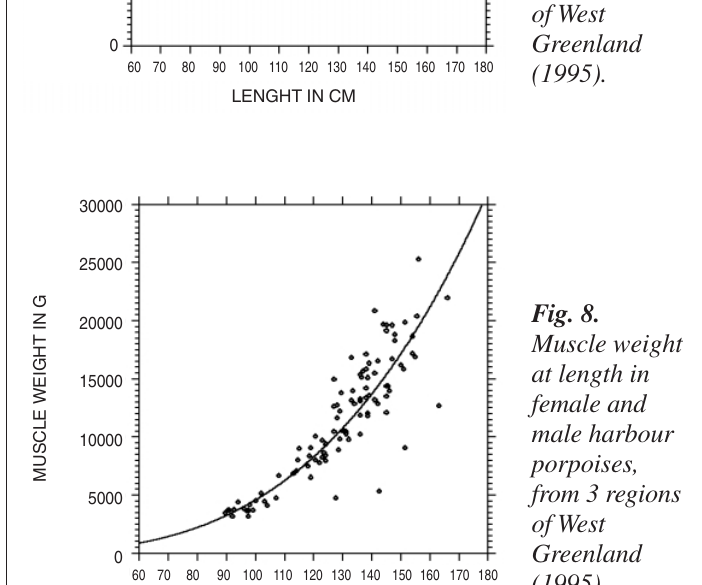
Fig. 7. Blubber weight at length in female and male harbour porpoises, from 3 regions of West Greenland (1995).